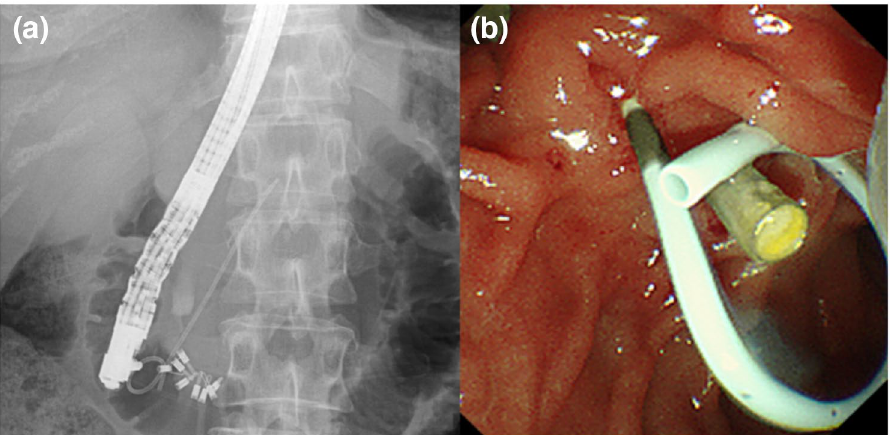
Figure 2. A case of pancreatic duct stenting using the novel 4-Fr plastic stent. ( a ) Fluoroscopy, The 4-Fr stent has been placed in the pancreatic duct; ( b ) Endoscopy, The single-pigtail and the black marker of the proximal side are exposed to the